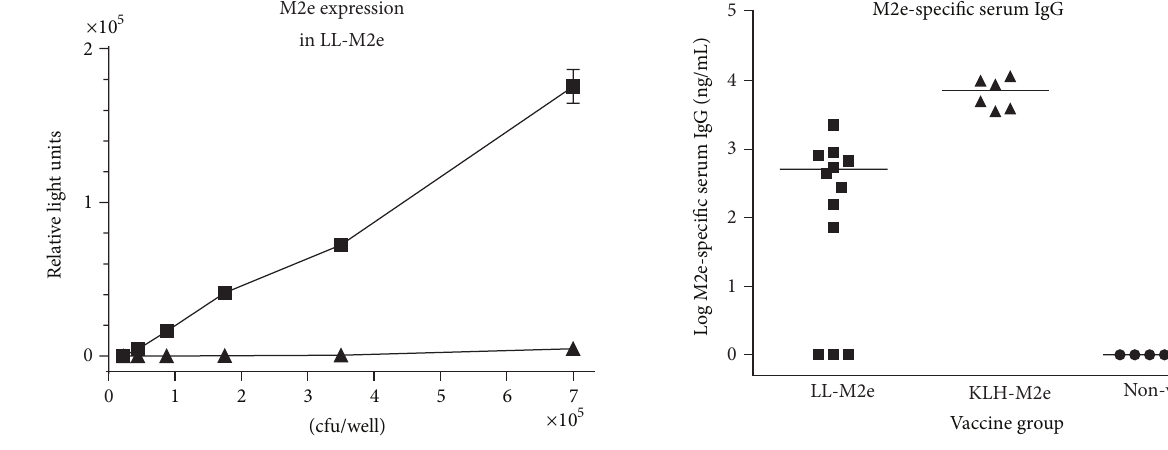
Figure 2: Expression of M2e from L. lactis . A 1/2 serial dilution of LL-M2e washed cells was bound to a 96-well microtiter plate and analyzed by ELISA. Cell surface-bound M2e was detected by adding a constant amount/well of preimmune ( 󳵳 ) or postimmune ( ◼ ) rabbit polyclonal M2e antiserum. Expression of M2e protein on the surface of LL vector with no M2e gene was not detected using preimmune and polyclonal antibodies (data not shown). The signal wasdevelopedwithsecondaryantibodyanti-rabbitIgG-horseradish peroxidase conjugate and chemiluminescent substrate. Error bars indicate standard deviation. Three independent experiments were conducted ( 𝑛 = 3 ).